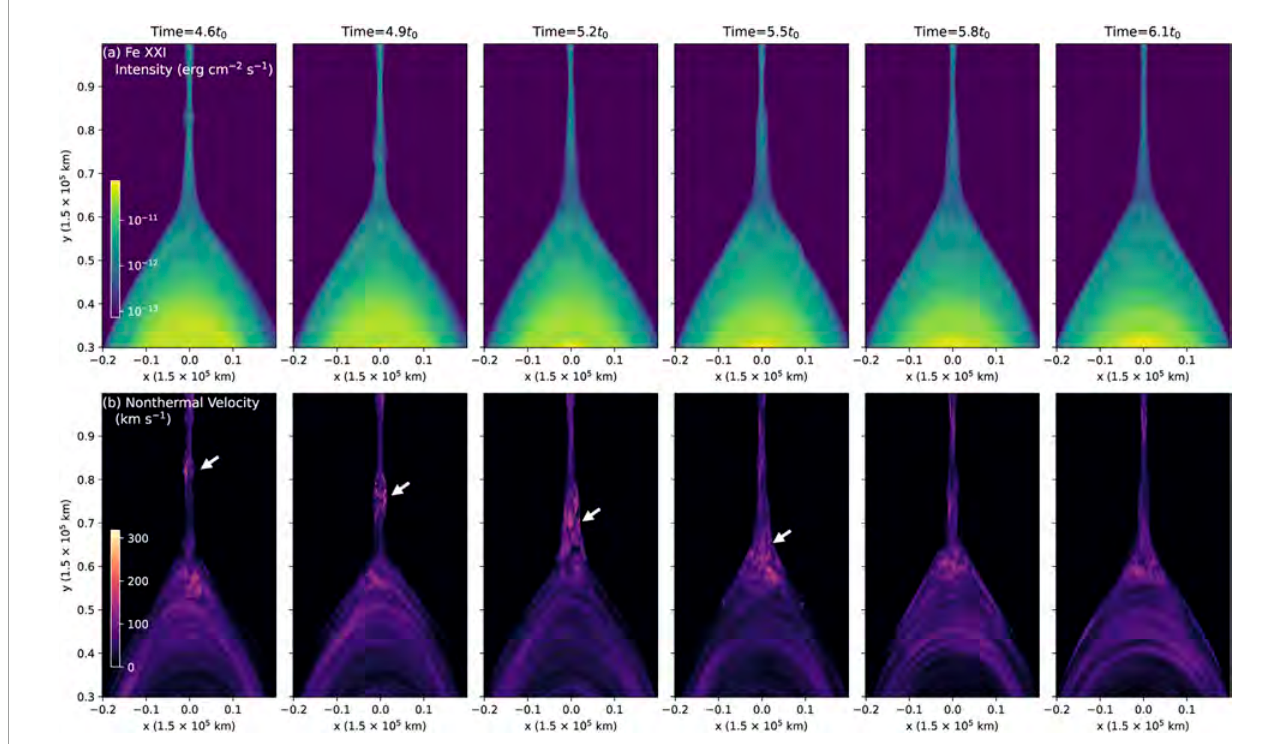
FIGURE 8 Synthetic Fe XXI 1354 Å emission maps at different times. (A) The peak intensity of 1354 Å spectra line during time t = 4 . 6 t 0 to 6 . 1 t 0 , (B) The deduced non-thermal velocity ( v nth ) . The white arrows annotate the downward moving high v nth